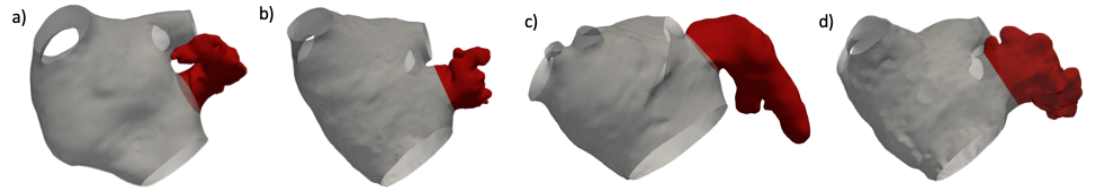
Figure 3. Example of 3D models for each LAA morphologies: Chicken wing ( a ), Cauliflower ( b ), Windsock ( c ) and Cactus ( d ).